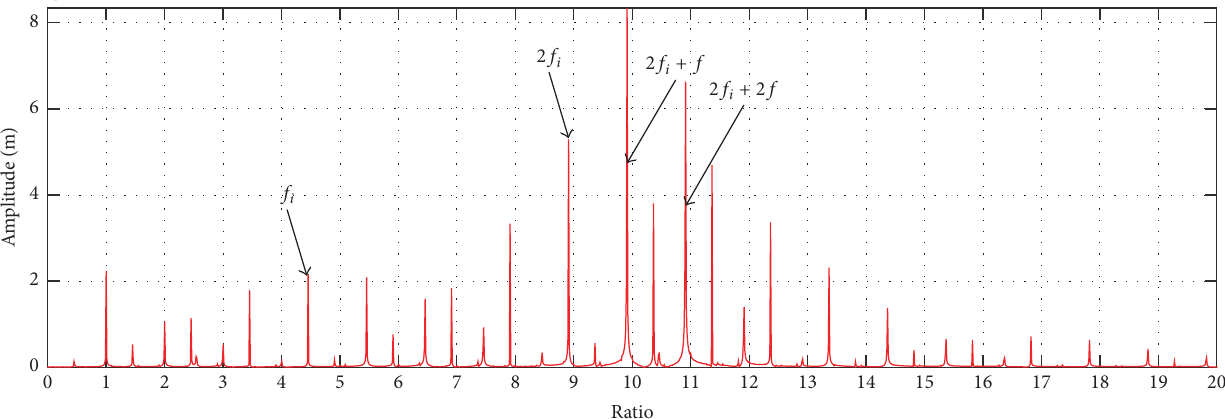
Figure 8: The spectral diagrams of the fault system with bearing inner race defect at 𝜔 = 100 rad/s and width 1𝑒 − 3